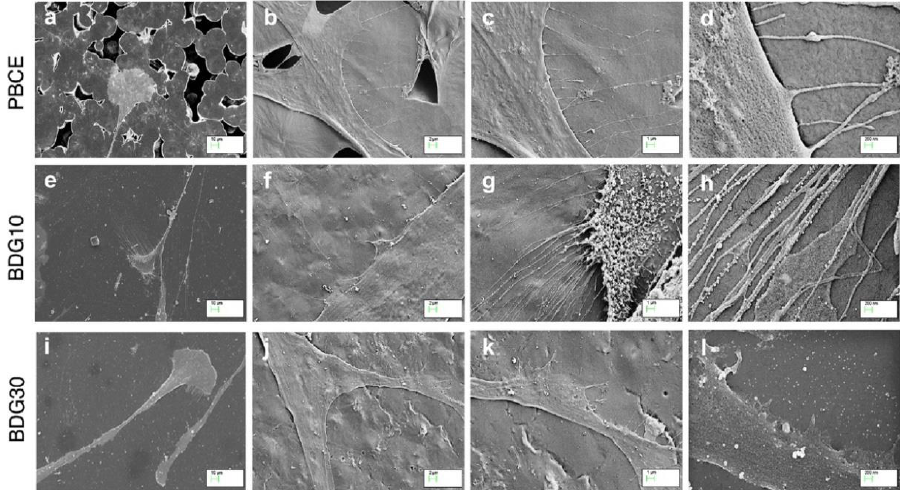
Figure 5. Interaction of hBM-MSCs with the surface of PBCE, BDG10 and BDG30. FESEM representative images at different magnifications (( a , e , i ) : 10 μm; ( b , f , j ): 2 μm; ( c , g , k ) : 1 μm; ( d , h , l ): 200 nm) revealed the interaction of hBM-MSCs on polymer films surfaces.